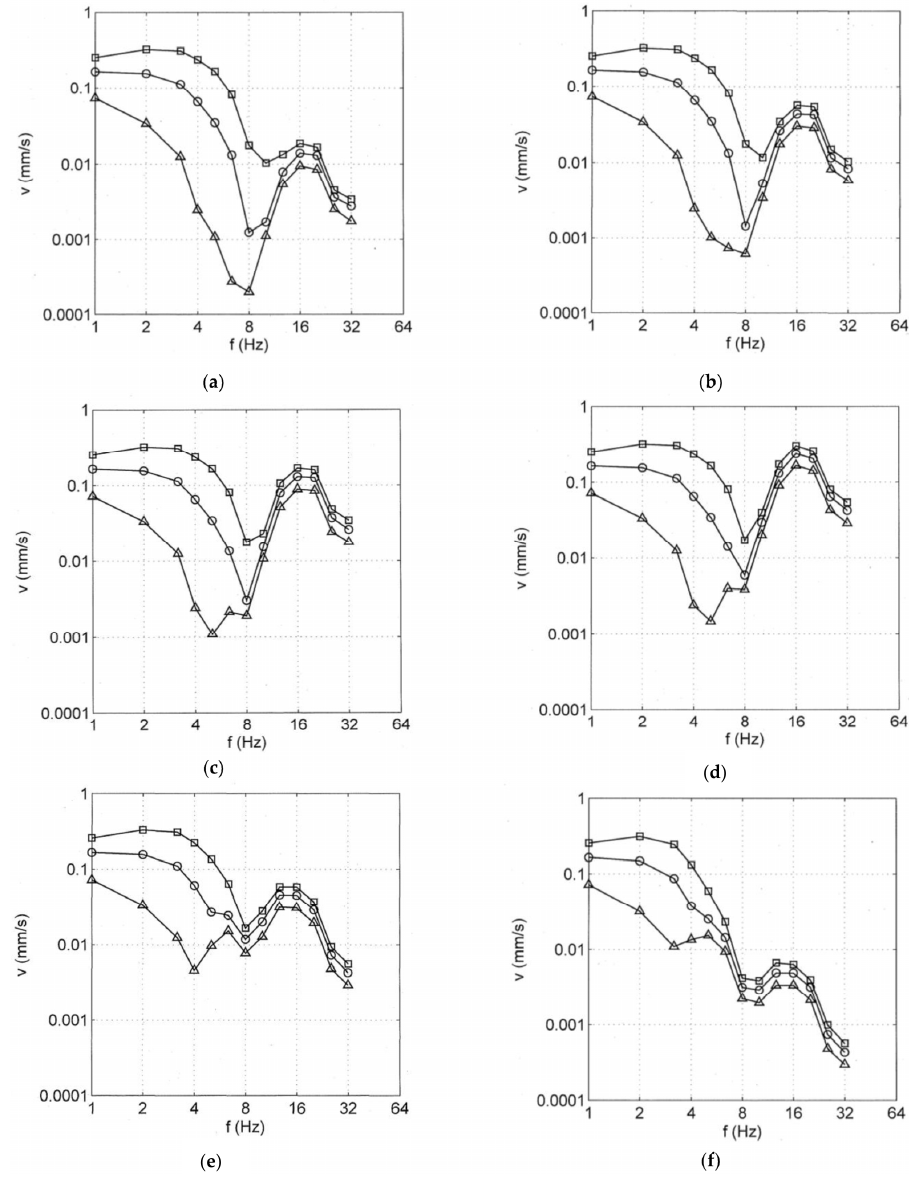
Figure 7. Train passage with v T = 160 km/h over an irregular track and a soil with v S = 200 m/s, irregularity q = ( a ) 3%, ( b ) 10%, ( c ) 30%, ( d – f ) 50%, track stiffness ( a – d ) EI ballast track, ( e ) 10 EI , ( f ) 100 EI slab track, one-third of the octave band spectrum at distances x = □ 3, ○ 5, ∆ 10 m.